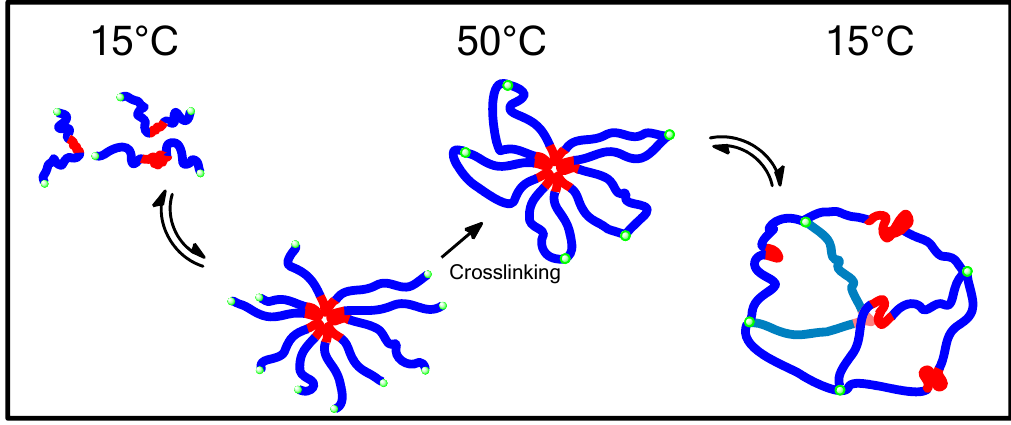
Figure 7. Formation of nanocages from polymers of PEG (blue) PPG (red) and methacrylate groups